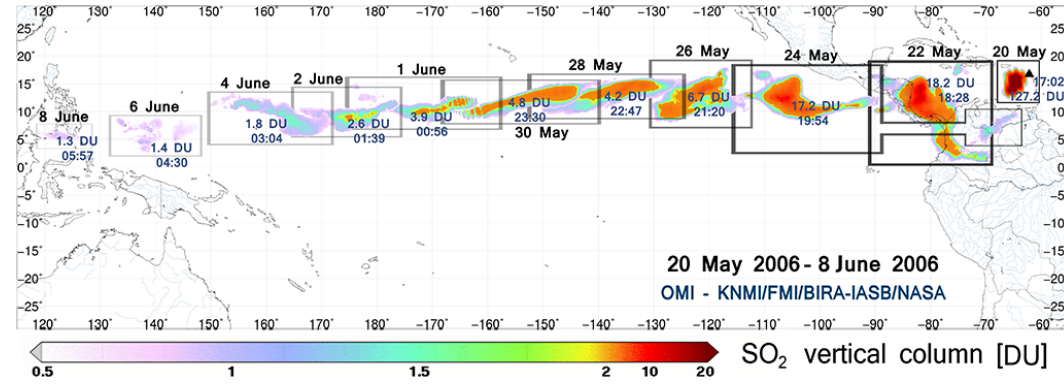
Fig. 14. OMI images of SO 2 emitted by the Soufrière Hills volcano from 20 May to 8 June 2006 (from right to left).